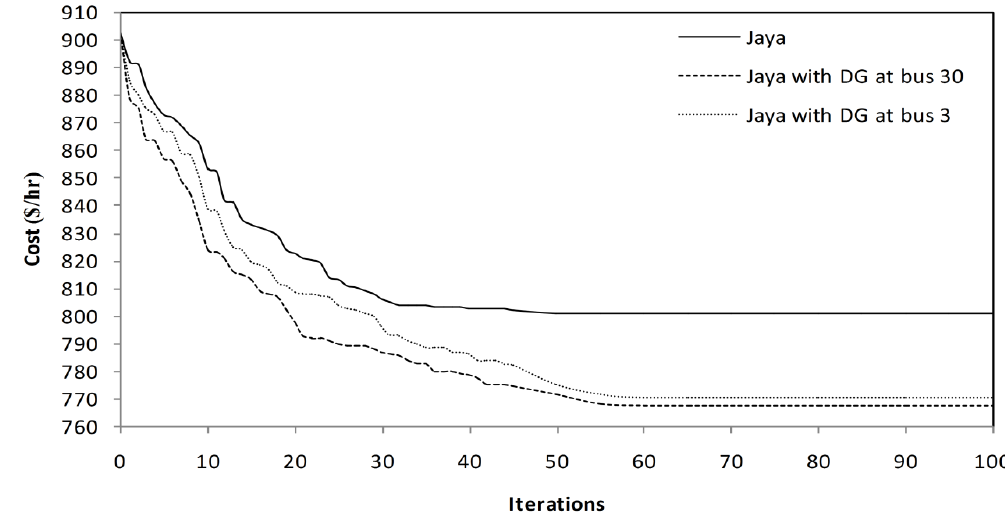
Figure 4. Convergence graph of fuel cost minimization using the Jaya algorithm with and without employing DG.